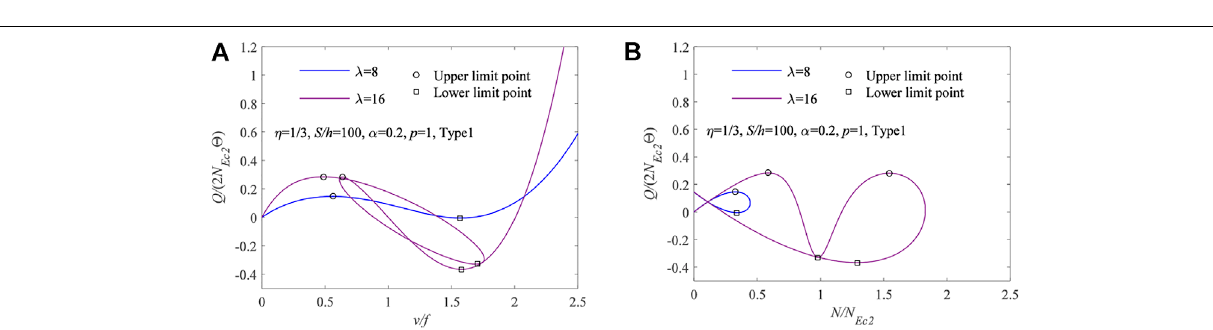
N / N − Q /( 2 N Θ ) curves are shown in Figure 7B . In Figure 7 Ec 2 Ec 2